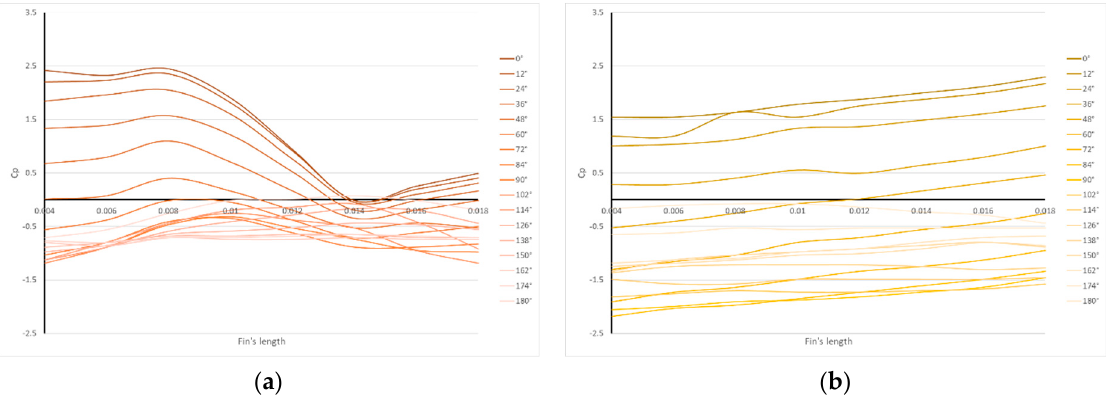
Figure 1. Experimental results of the pressure coefficient distribution: ( a ) internal surface and ( b ) external surface of the inclined fin.